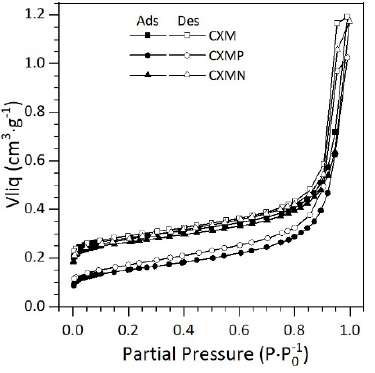
Figure 2. Nitrogen isotherms of carbon xerogel microspheres (CXMs) and CXMs functionalized with melamine (CXMN) and phosphoric acid (CXMP). Adsorption curve—filled symbols; desorption curve—unfilled symbols.